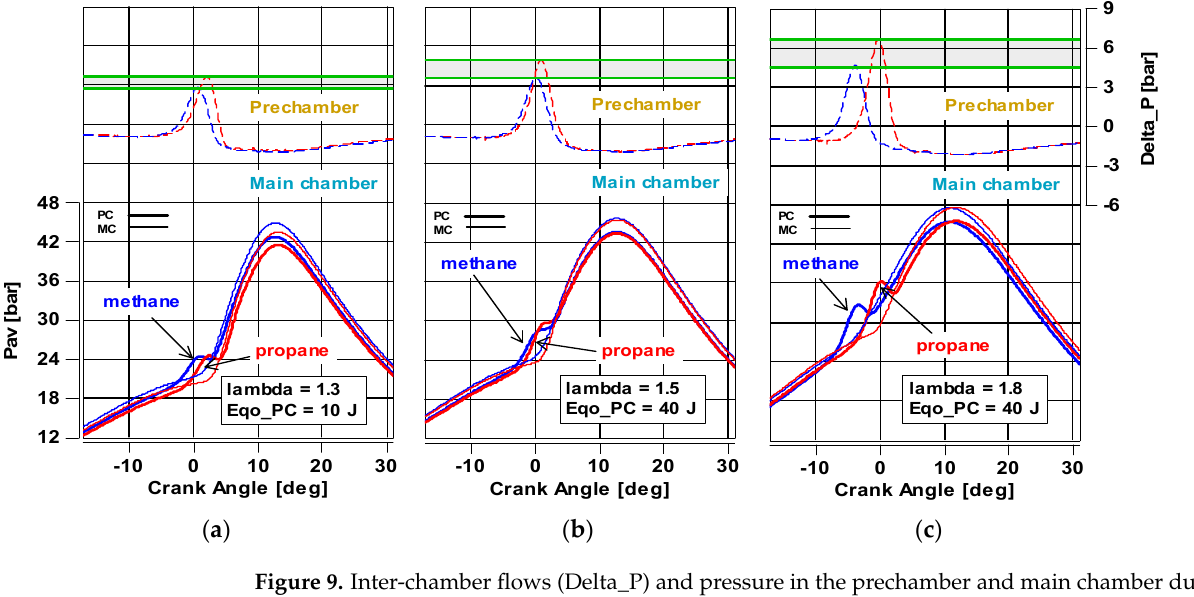
Figure 9. Inter-chamber flows (Delta_P) and pressure in the prechamber and main chamber during combustion of methane (blue line) and propane (red line): ( a ) during combustion of fuels with excess air λ = 1.3; ( b ) during combustion of fuels with excess air λ = 1.5; ( c ) during combustion of fuels with excess air λ = 1.8.